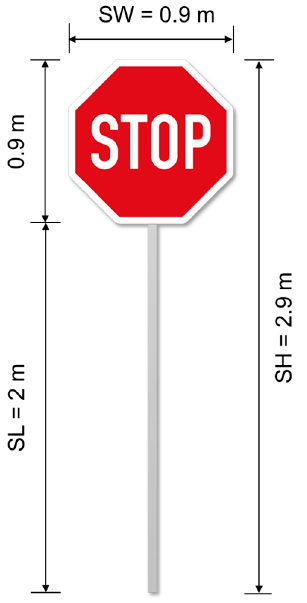
Figure 2. Standard-sized stop signs in this study.